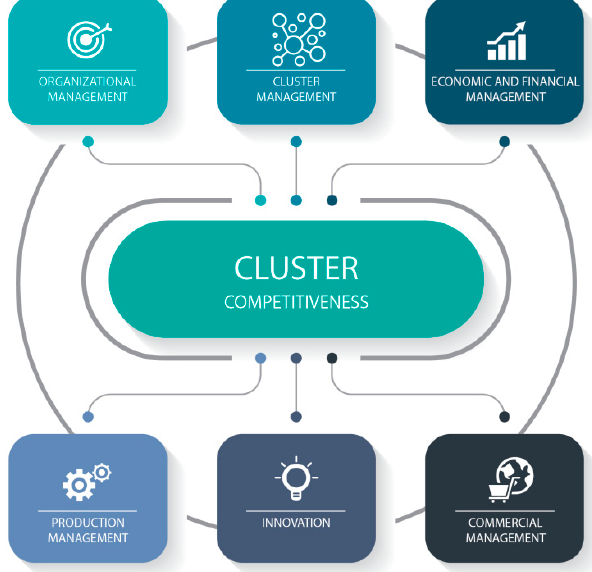
Figure 2. Factors a ff ecting Cluster Figure 2. Factors affecting Cluster Competitiveness.